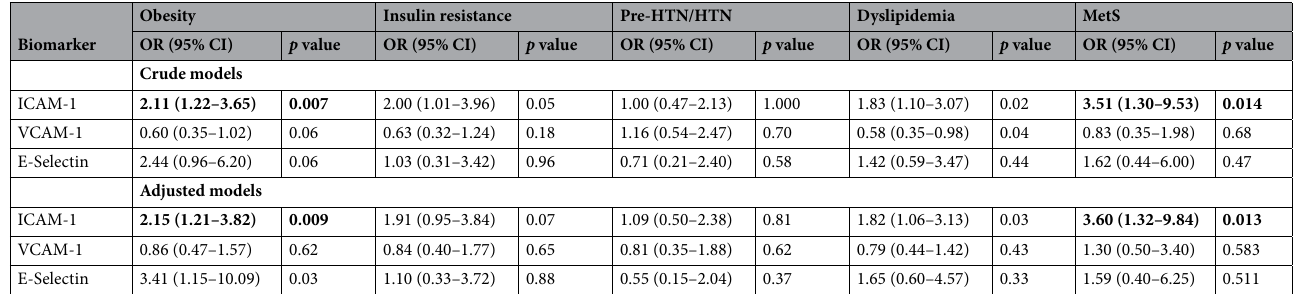
Table 6. Associations between biomarkers of endothelial function and cardiometabolic complications in survivors of childhood acute lymphoblastic leukemia: crude and adjusted models. The crude and adjusted models were assessed between each biomarker and each cardiometabolic outcome. Models were adjusted for CRT exposure, age at diagnosis, time since diagnosis and sex. Odds ratio (non-corrected 95% CI) and p-value are indicated for each association. Bonferroni-adjusted alpha = 0.05/number of biomarkers = 0.05/3 = 0.017. Metabolic syndrome was defined according to the International Diabetes Federation. CI: confidence